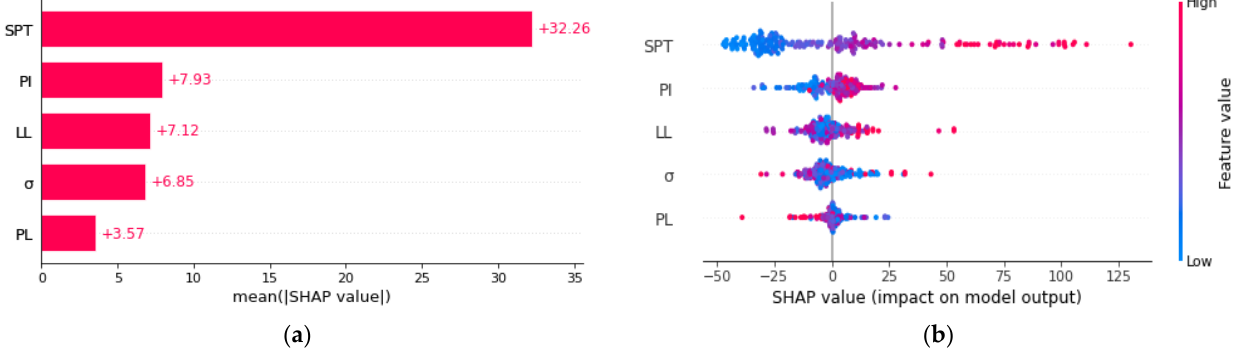
Figure 9. The variable importance for prediction models: ( a ) the average SHAP value of each input variable; ( b ) the sum of the SHAP value magnitudes of the input variables on all samples.